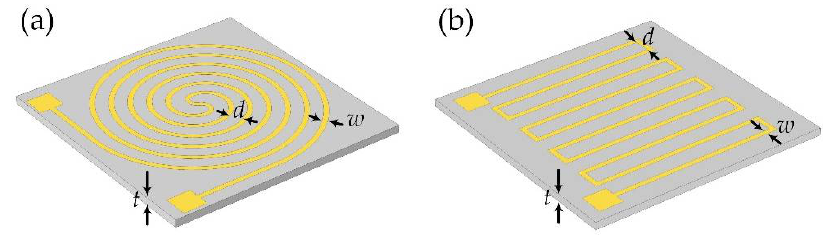
Figure 2. Two kinds of heating structures were studied in this study, ( a ) the Circular-shaped structure, and ( b ) the S-shaped structure.